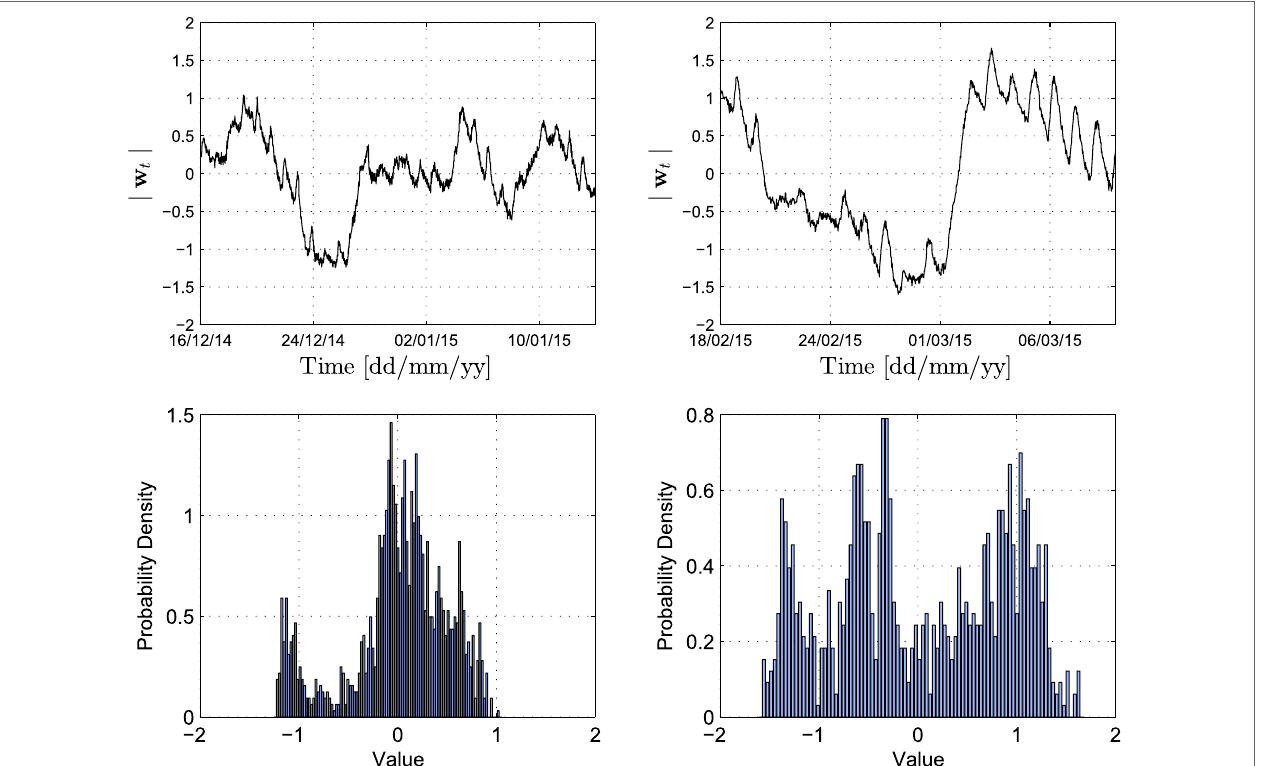
FIGURE 8 | Top: PCA prediction error for the estimation (left) and validation set (right) of sensor F2 . Bottom: histograms of the prediction error for each set.